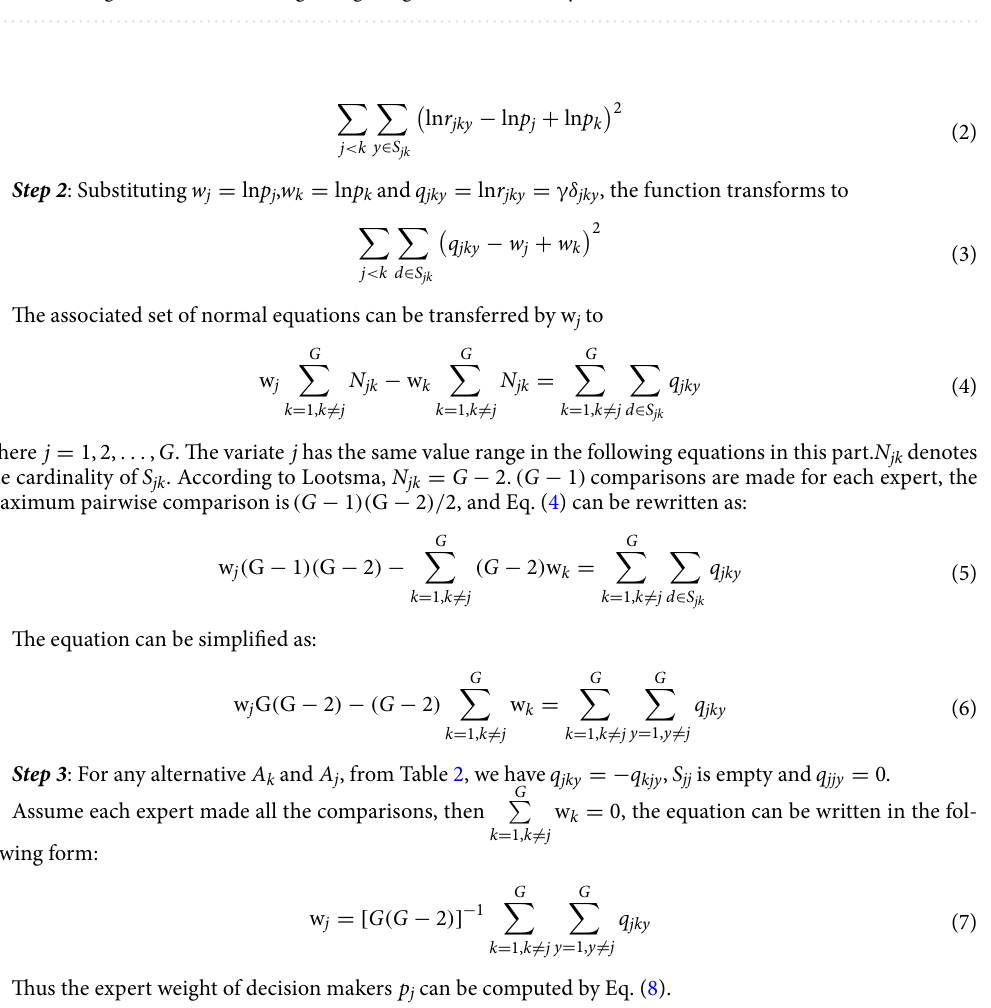
Table 2. Integer-valued index designating the gradations made by decision makers 24